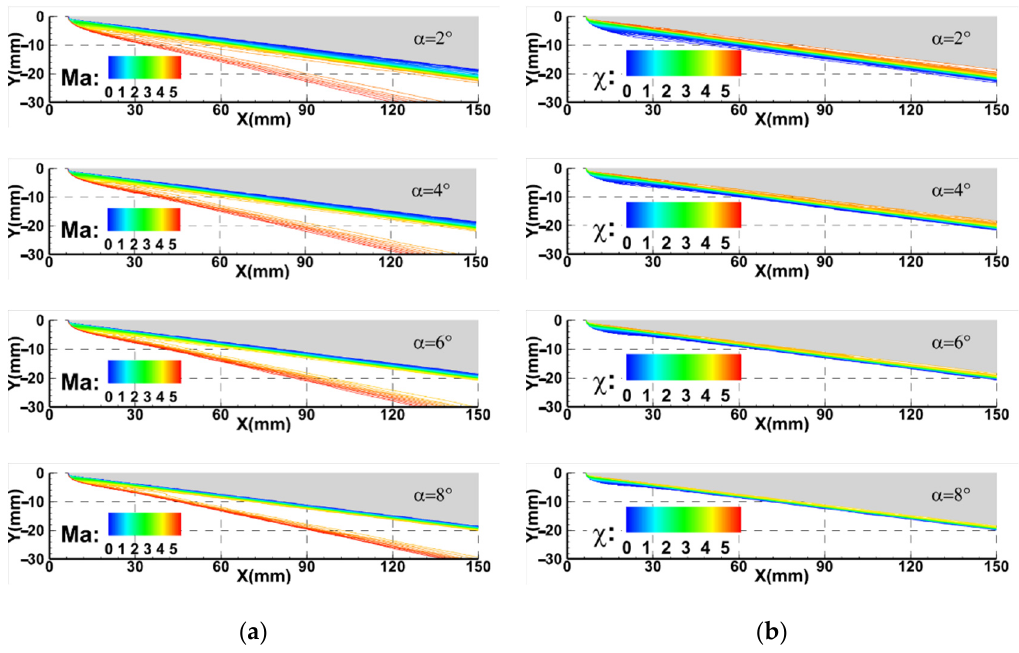
Figure 18. Distribution of Ma and χ contour without an aerodisk on the symmetry plane at different α . ( a ) Ma contour, ( b ) χ contour.